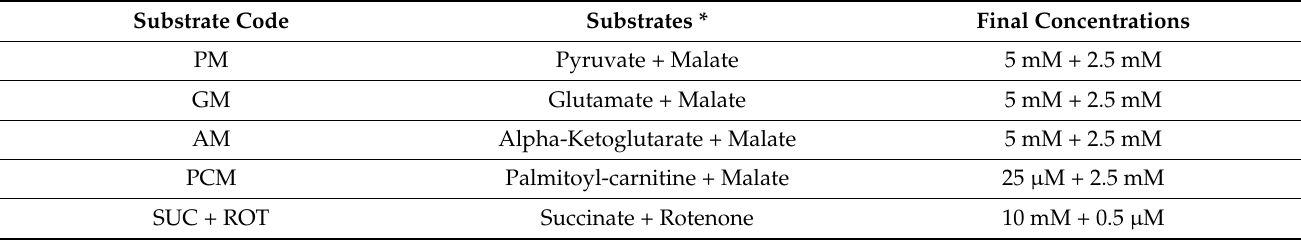
Table 1. Substrate combinations that were used to measure mitochondrial respiration.